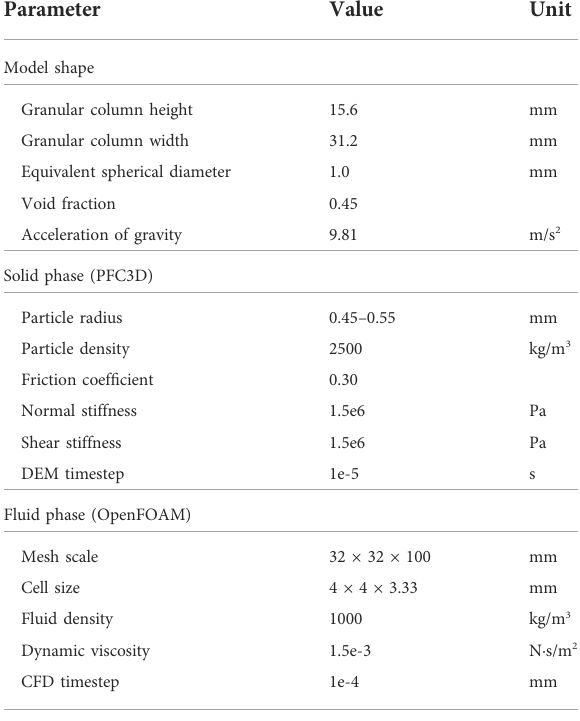
TABLE 1 Detailed parameters adopted in the numerical Ergun test. TABLE 2 Geometrical and strength parameters of IGM